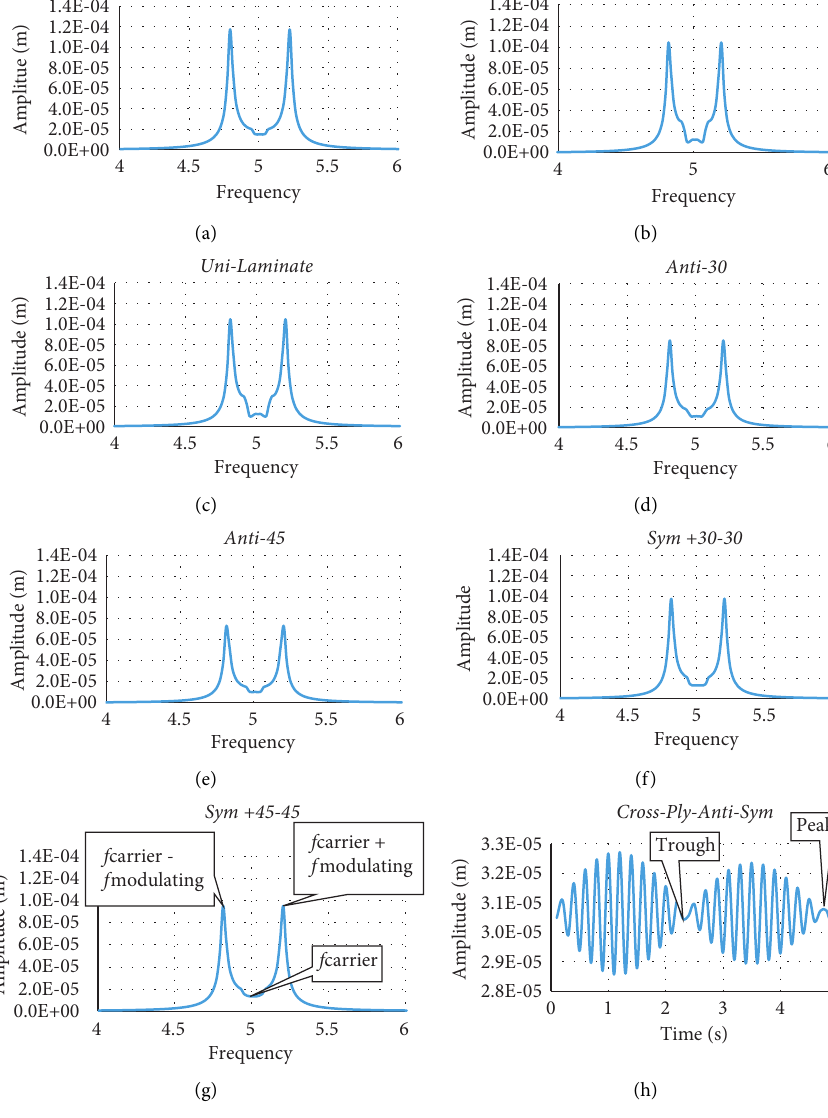
Figure 5: Illustration of the Fourier analysis for the output response of the laminates. The Sym+45 − 45 laminate graph shows both carrier and modulating frequencies. The last graph is an enlarged sample of response for cross-ply antisymmetric laminate that shows the trend of amplitude